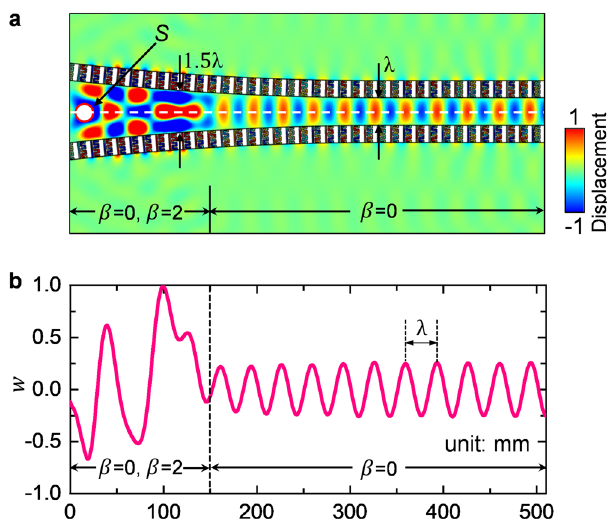
Fig. 6 Flexural wave pattern excited by a point source in a waveguide with gradient width. a The out-of-plane displacement wave fi elds. The point source S is placed in the middle of waveguide. β refers to the guided- mode order. With the decrease of waveguide width, the guided-mode orders transit from β = 0, 2 to β = 0 smoothly. b The out-of-plane displacement w along the central line of the waveguide (the white dashed line in a ). The waveform in the part of β = 0 is quite regular with a wavelength λ and has an almost constant amplitude. It is illustrated that the waveguide can rectify distorted incident waves to permit the